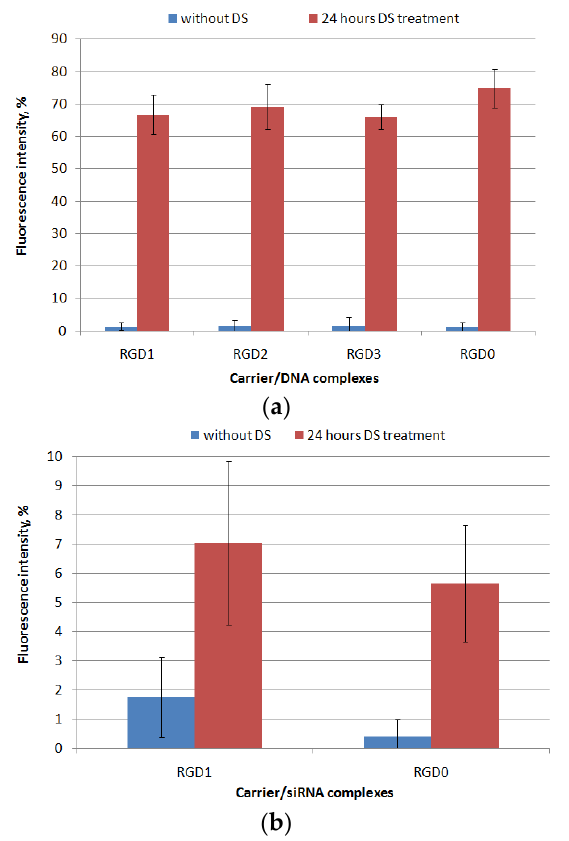
Figure 4. Relaxation of peptide/DNA ( a ) and peptide/siRNA complexes ( b ) at N/P ratio 8/1 after 24 h of DS treatment (three-fold charge excess). A total of 100% of fluorescence intensity corresponds to free DNA stained with EtBr or free siRNA stained with SybrGreen. Values are the mean ± SD of the mean of triplicate experiments.